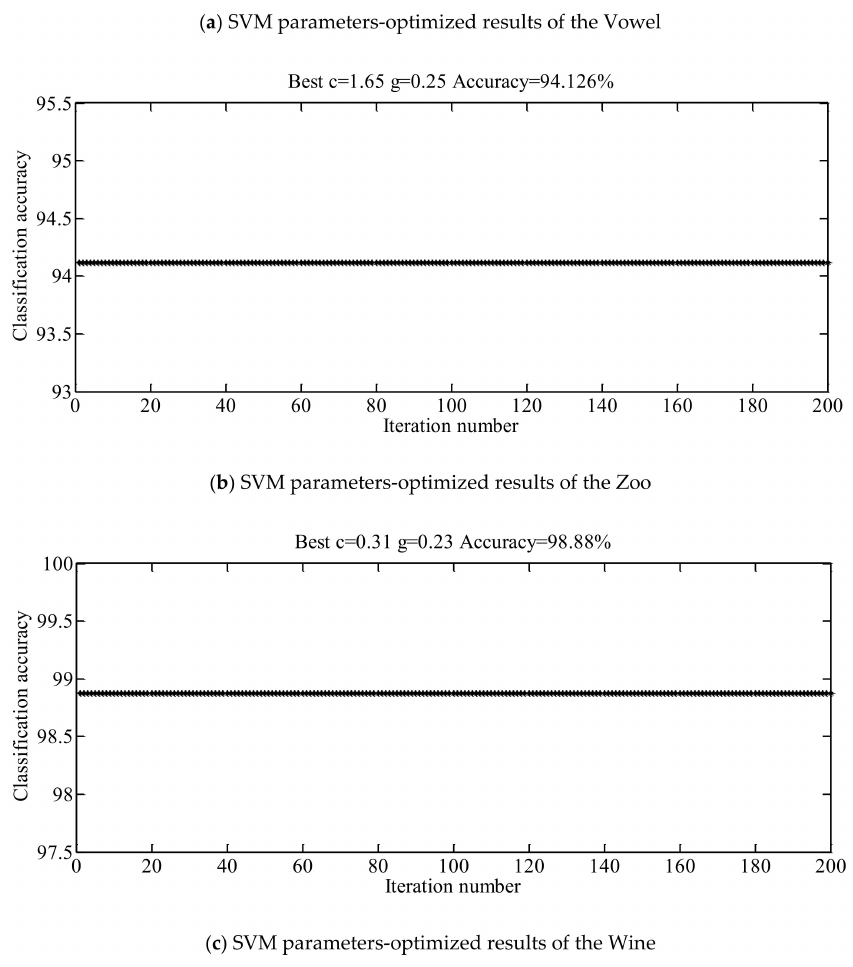
Figure 6. SVM parameters optimized results of the UCI data sets.